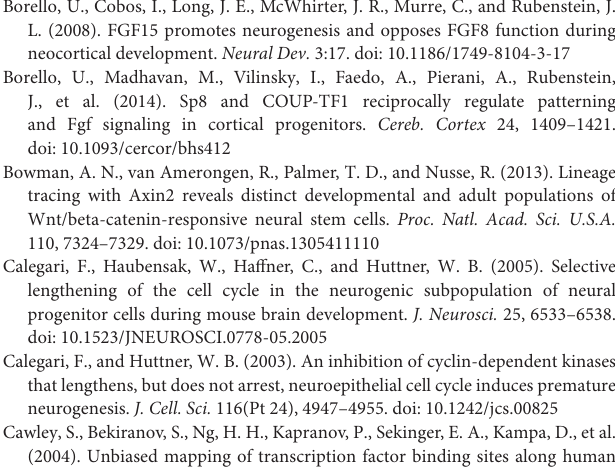
(PAX6S), the predicted PAX6 binding site, and the ATG are indicated. The nt positions refer to the Ccnd1 TSS1; SP8 (G) site position is indicated as 164 nt downstream of the exon 1 ORF. The SP8 A-E sites are located in the promoter region; SP8 (F,G) sites are the closest to the SP8 summit. Positions of the SP8S and PAX6S are indicated in bold and underlined. Figure S2 | Predicted SP8 binding sites on Ccnd1 Ex5 fragment. The 7 predicted SP8 sites from Table S2 (A–G) , the SP8 summit (SP8S), and the stop codon (TGA) are indicated. The nt positions refer to the Ccnd1 TSS1; SP8 (A,B) position is indicated as 125 nt upstream of the exon 5 ORF. Position of the SP8S is indicated in bold and underlined. Figure S3 | Pax6 and Axin2 expression at E12.5. ISH on E12.5 mouse forebrain coronal sections. Panel (A) shows Pax6 expression in the rostral forebrain and panel (B) shows Pax6 expression in a more caudal section, panel (C) shows Axin2 expression, as proxy of the Wnt pathway activity, in the rostral forebrain and panel (D) shows Axin2 expression in a more caudal section. Bar in (A) : 200 µ m. Figure S4 | Sp8 expression analysis in the Sp8 LOF and GOF mutants at E12.5. E12.5 mouse forebrain coronal sections . Sp8 mRNA expression levels are shown in the control (A) and Sp8 LOF mutant (C) , immunofluorescence of EGFP (B) is shown as a proxy of Sp8 overexpression in the GOF mutant (Borello et al., 2014). Bar in (A) : 200 µ m. Figure S5 | Genome-wide distribution of the SP8 binding sites on gene features. Plot showing the percentage of the SP8 binding sites distributed genome-wide on gene features. Table S1 | SP8 and H3K27ac ChipSeq fragments identified on the Ccnd1 locus. MACS results of the SP8 and H3K27ac ChipSeq peak calling. Position of the peaks summits is indicated. The column “name” indicates the genomic fragment names used in this study. The fragment named Ex1.2.3 in the H3K27ac ChipSeq dataset contains Ccnd1 promoter, 5 ′ UTR, and exons 1–3; fragment Ex5 contains Ccnd1 exon 5 and 3 ′ U TR. Table S2 | Bioinformatic analysis using the Jaspar software (Mathelier et al., 2016) of the Ccnd1 Ex5 fragment. Position of the predicted SP8 sites refers to the Ex5 fragment full sequence, nt 1-889. Table S3 | Ccnd1 expression levels in the Sp8 GOF and LOF mutants. Results of RNASeq analysis on Sp8 mutants obtained with DESeq2 (Love et al., 2014). Table S4 | Bioinformatic analysis of the Ccnd1 Ex1 fragment using the Jaspar software ( Mathelier et al., 2016). Position of the predicted SP8 sites refers to the Ex1 fragment full sequence, nt 1-1249. In bold are indicated the SP8 predicted sites in the Ccnd1 promoter (SP8 A–E) showing the highest score values, and the two SP8 sites (F,G) close to the position of the SP8 summit. The position of the predicted PAX6 site is